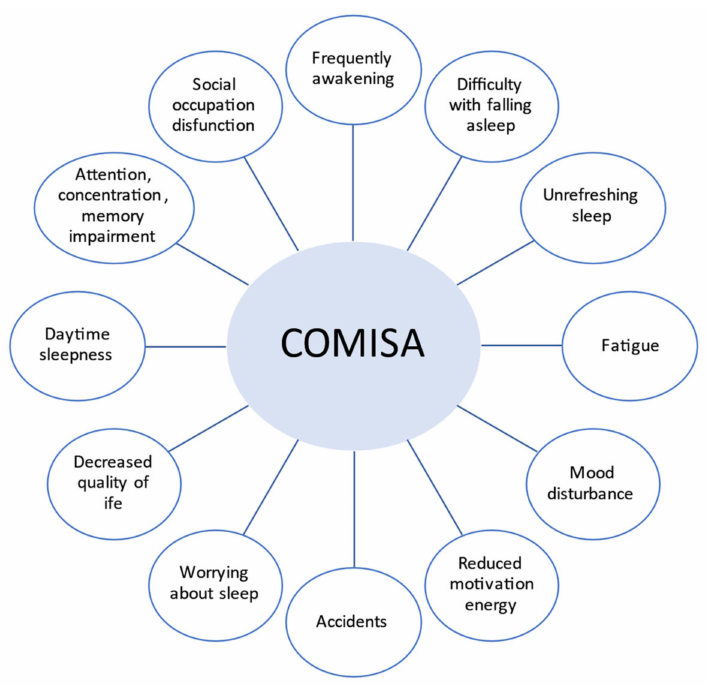
Figure 2. Symptoms of obstructive sleep apnea (OSA) and insomnia